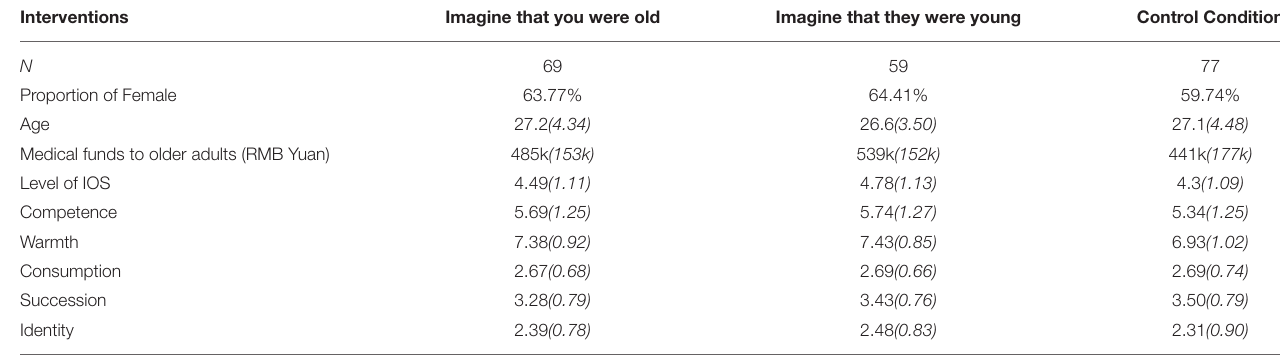
TABLE 1 | Main dependent and independent variables across three conditions [M( SD) ].